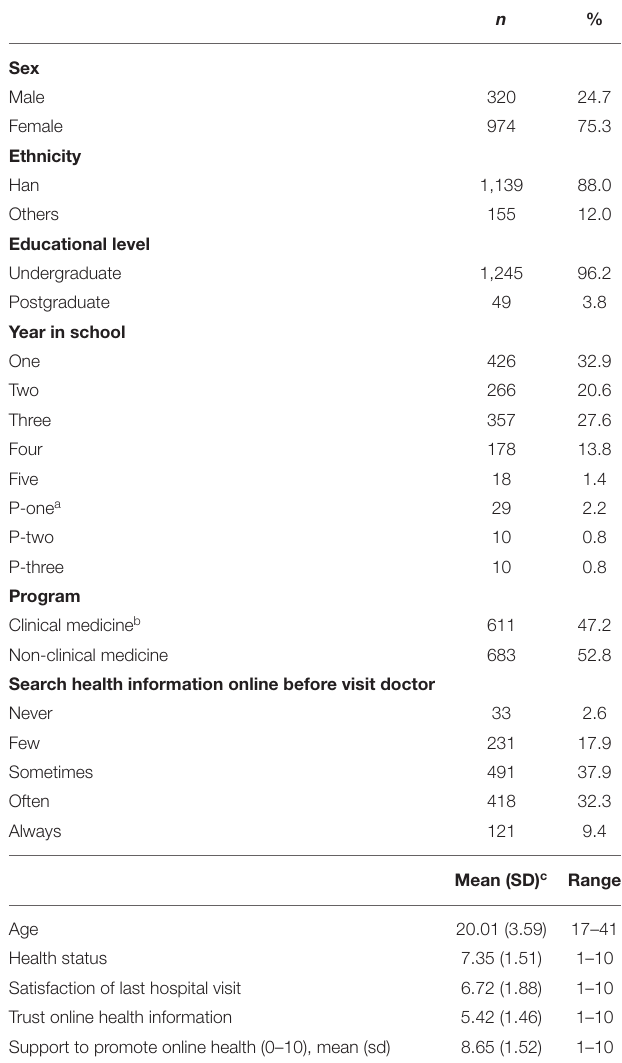
TABLE 3 | The demographics of the sample ( n =